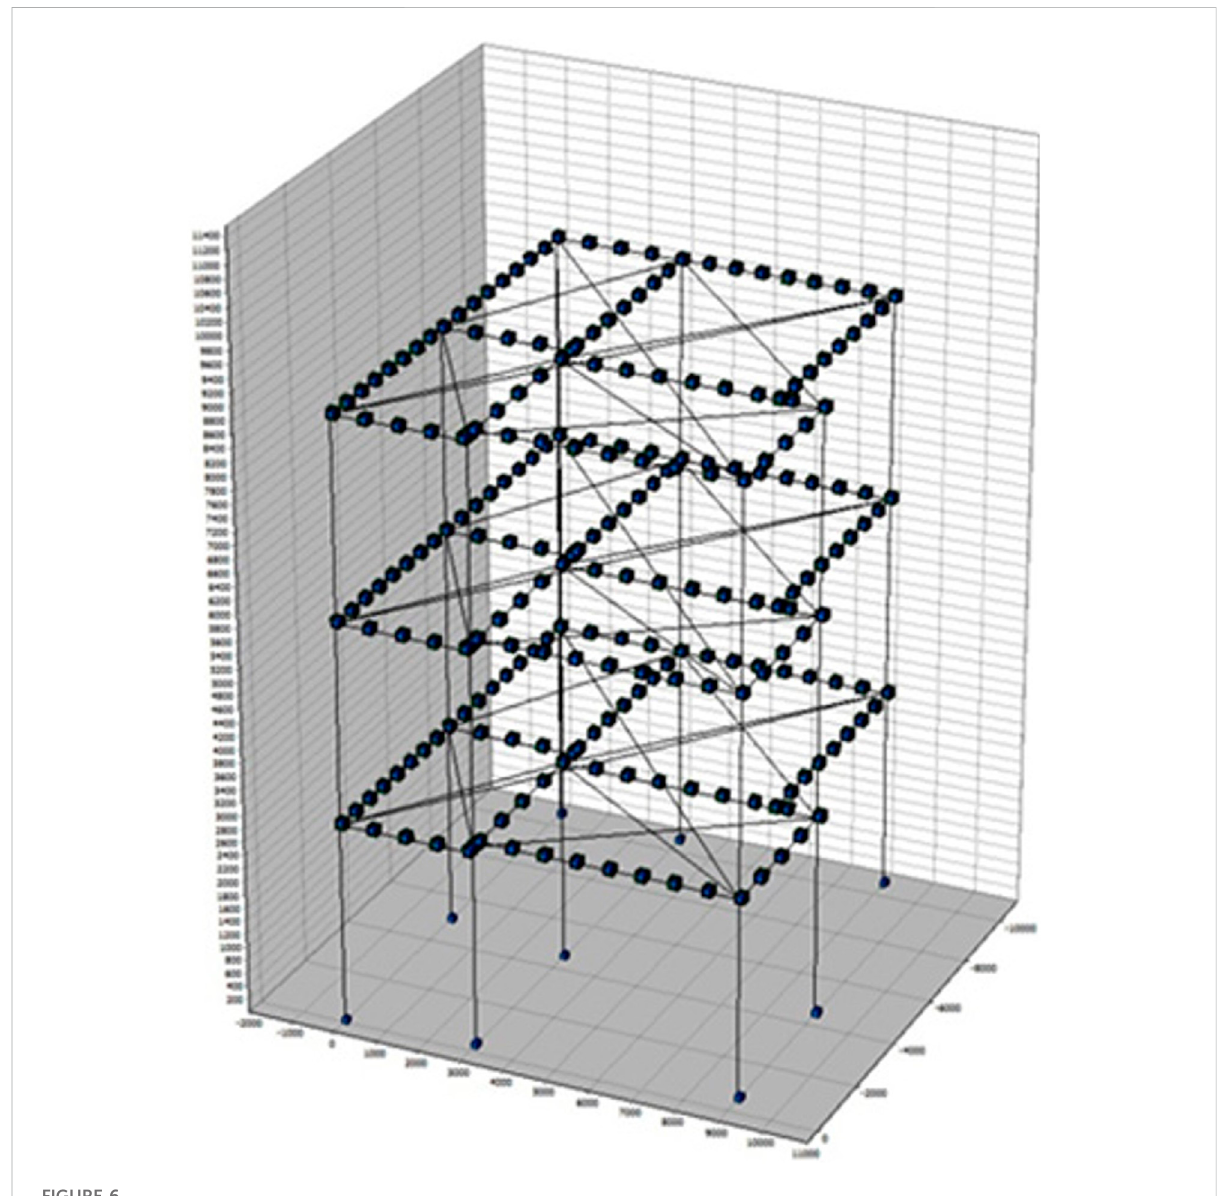
FIGURE 6 Finite element model of the SPEAR building.